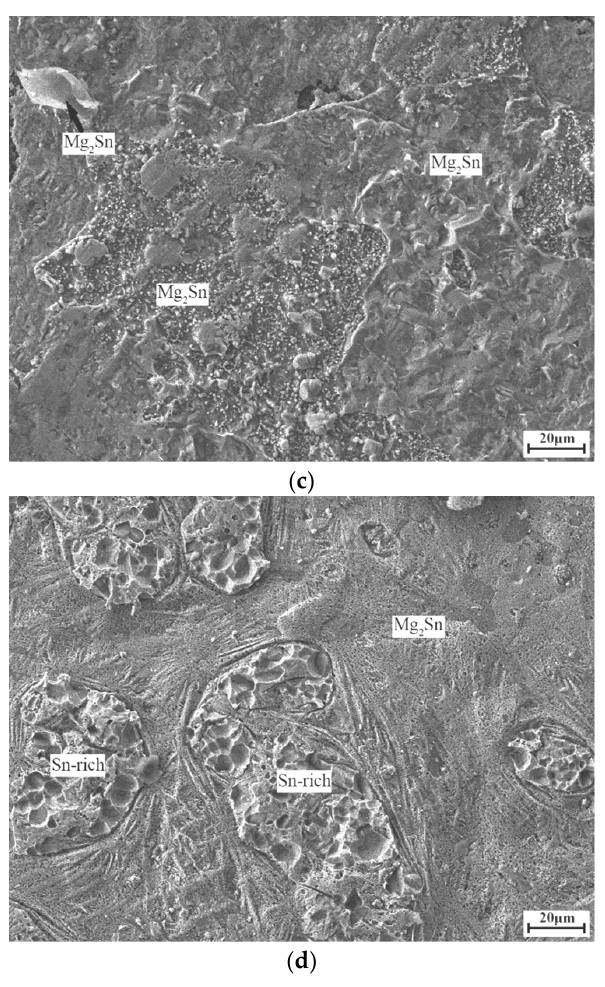
Figure 13. Fractographs of the AZ31 magnesium alloy/6061 aluminum alloy joints bonded with the Sn-5Zn-0.1RE filler metal after aging at 150 °C. ( a ) the 6061 aluminum alloy side after 50 h of aging; ( b ) the AZ31 magnesium alloy side after 50 h of aging; ( c ) the 6061 aluminum alloy side after 100 h of aging; ( d ) the AZ31 magnesium alloy side after 100 h of aging.